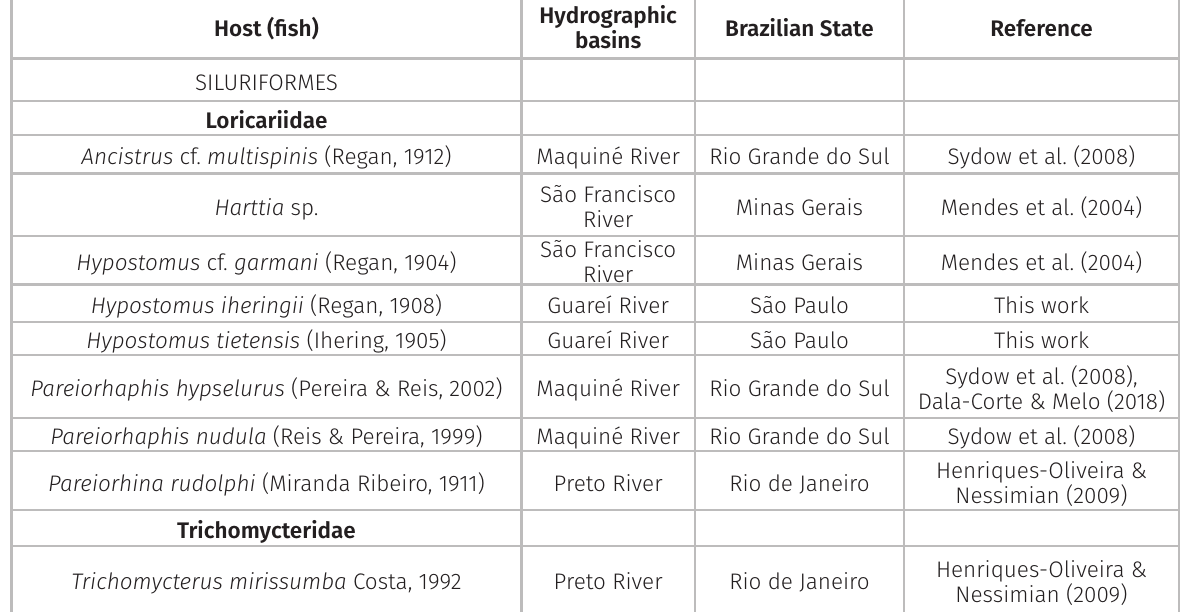
Table II. Fish species with records of Ichthyocladius lilianae on their body. Host